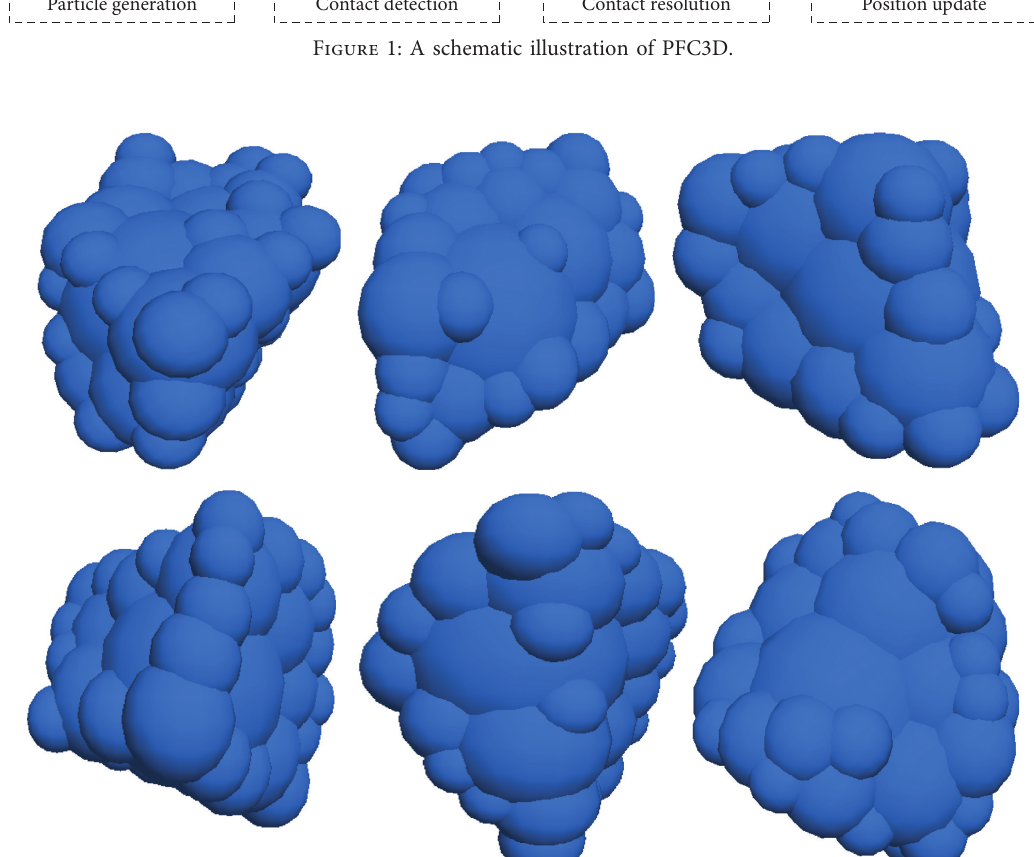
Figure 2: The six ballast clumps used in DEM models.